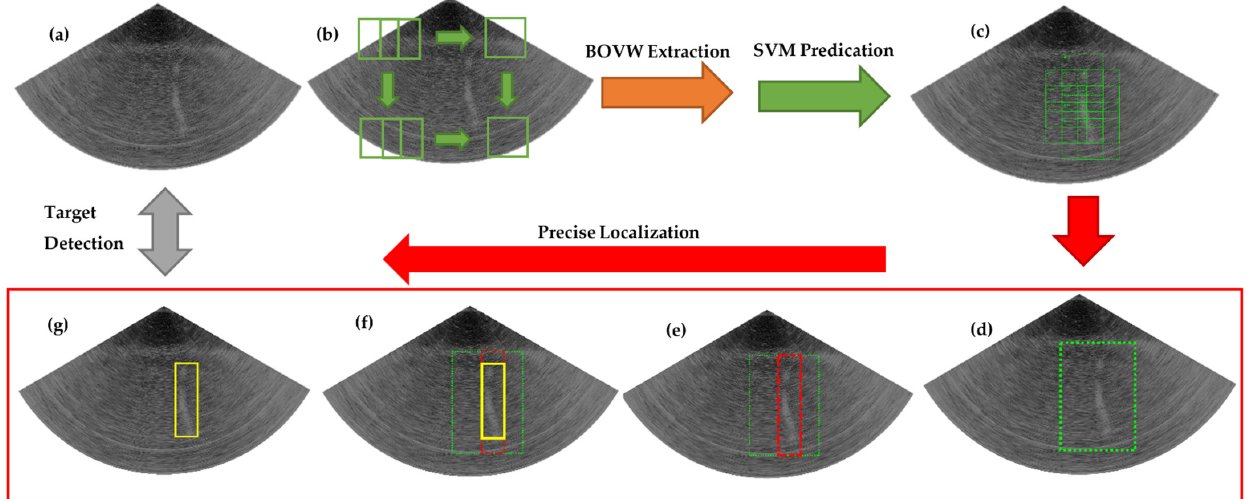
Figure 8. Target detection using SVM classifier and BOVW features. The processing steps are shown in ( a – g